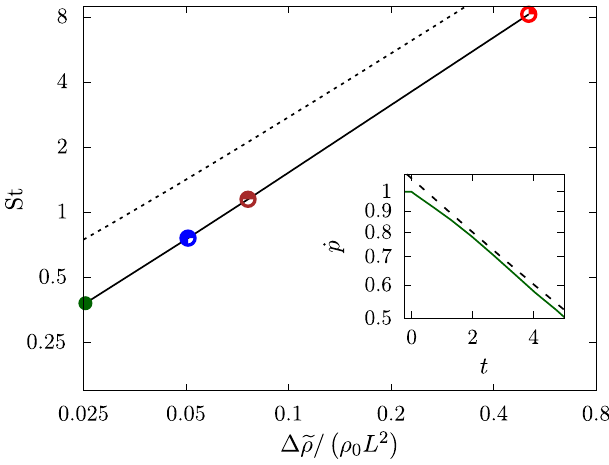
FIG. 1. Stokes number as a function of the linear density difference evaluated from the numerical simulations. Symbols and colors represent fibers with different values of Δ ˜ ρ . The dashed line reports the prediction obtained from Eq. (2). The inset shows the time history of the fiber angular velocity in one of our numerical tests (solid line) along with the exponential fitting curve (dashed